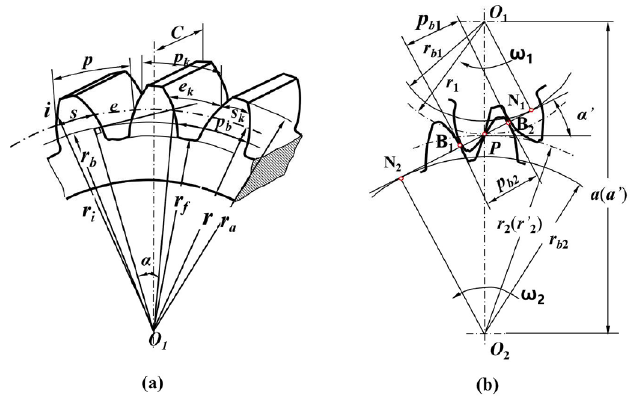
Fig. 1. Parameters of gear and